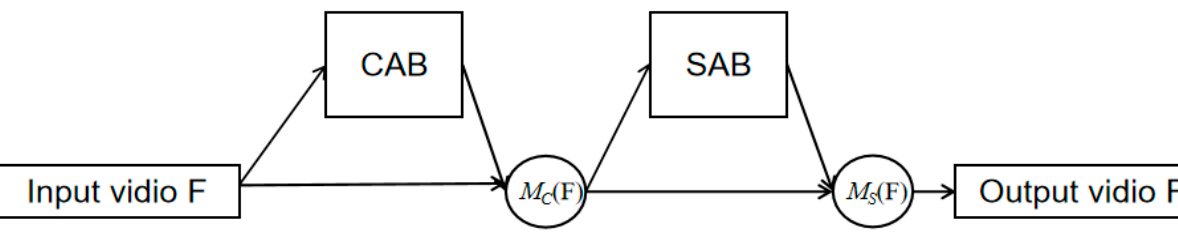
Figure 1. Fusion of CAB and SAB attention